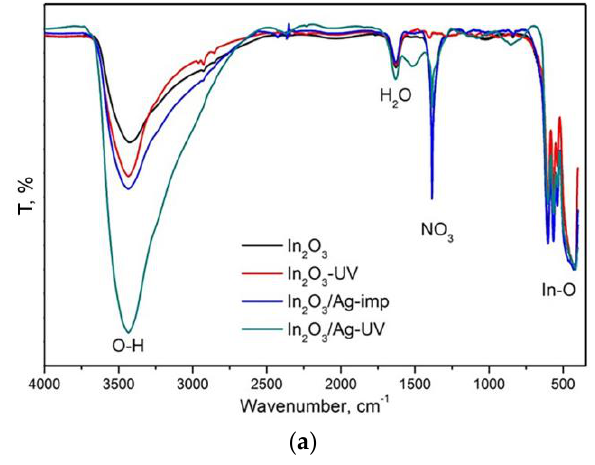
Figure 7. X-ray photoelectron spectra Ag 3d ( a ); In 3d ( b ); O1s ( c ) of the